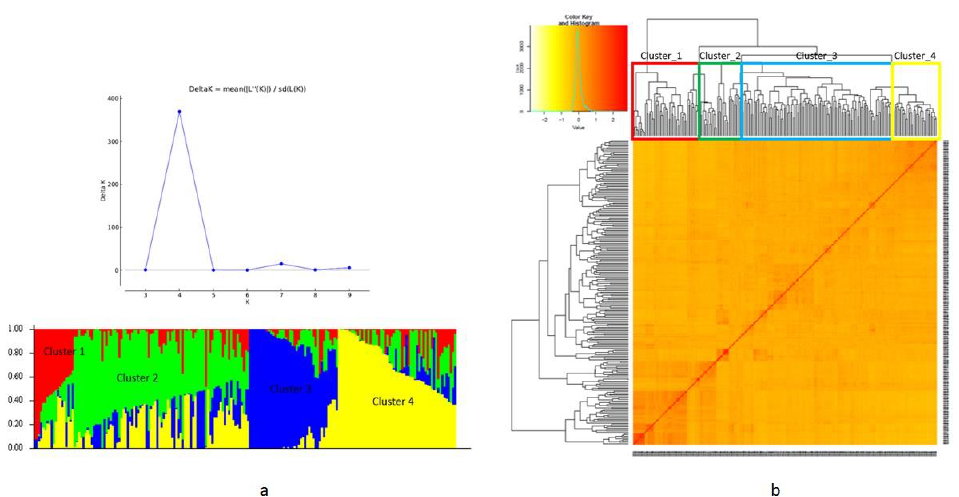
Figure 6. Population structure and kinship matrix of the wheat diversity panel based on 71,571 SNP markers: ( a ) STRUCTURE analysis and plot of delta K (1 to 10), and the presence of a peak at K = 4 hint at four subgroups. The 1st cluster (red), 2nd cluster (green), 3rd cluster (blue), and 4th cluster (yellow); ( b ) Heat map of the identity-by-descent based on genomic relationship matrices (GRM).